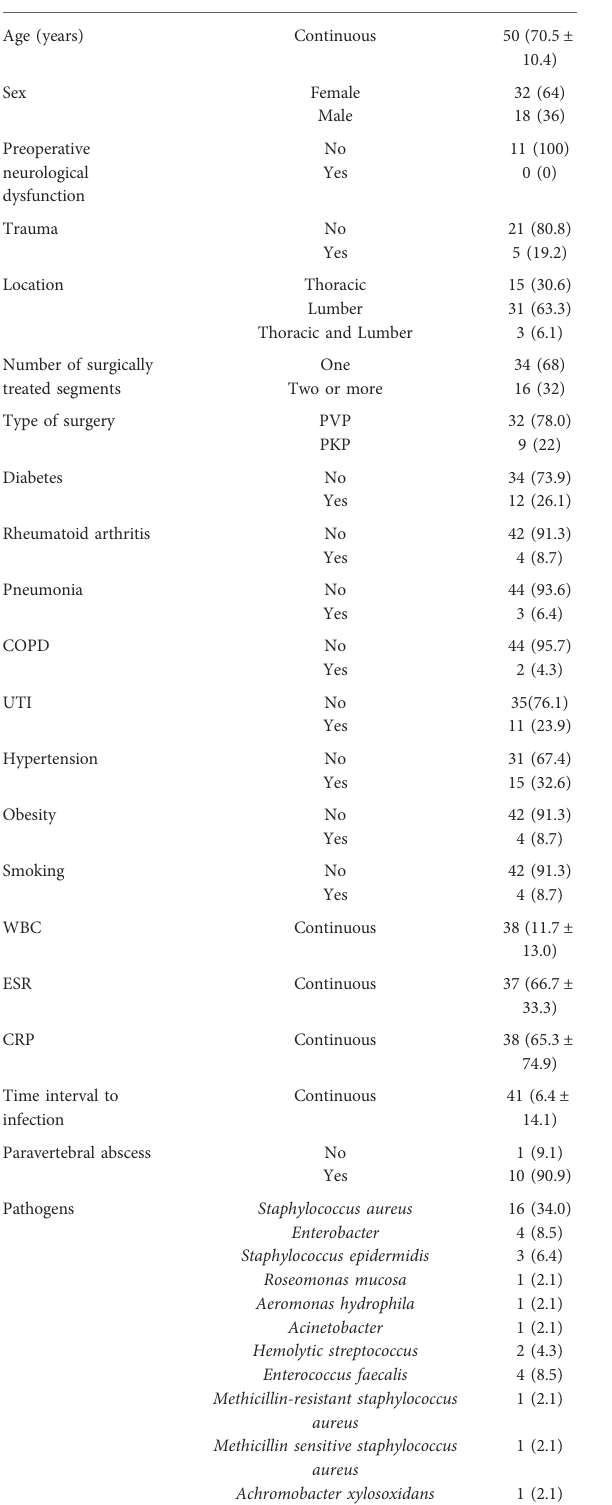
TABLE 2 Summary of the clinical characteristics in NTS